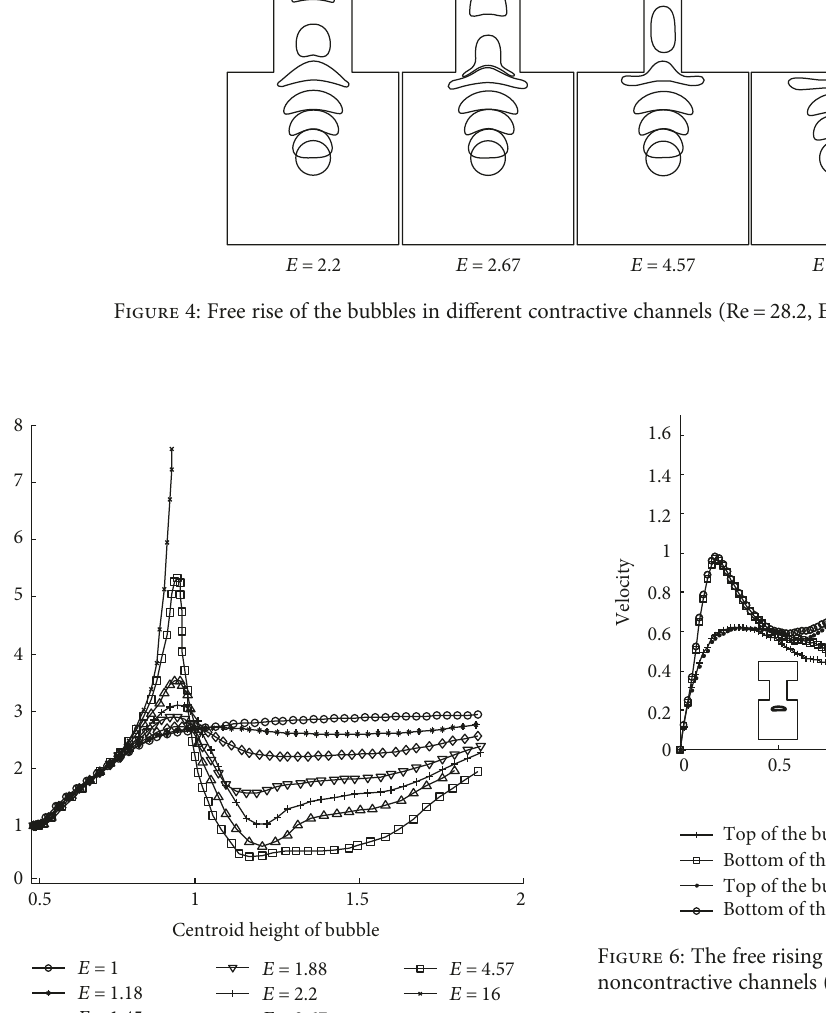
Figure 6: The free rising velocity of bubbles in the contractive and noncontractive channels (Re=70, Mo=8 × 10 − 5 , and